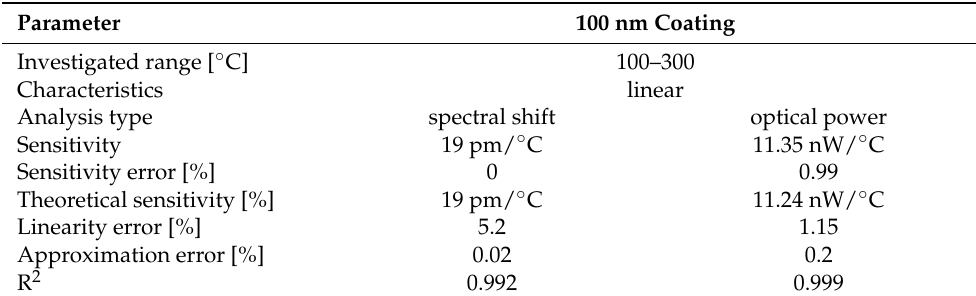
Table 1. Comparison between optical power and spectral shift analysis of parameters of the microsphere-based sensor with a 100 nm coating.